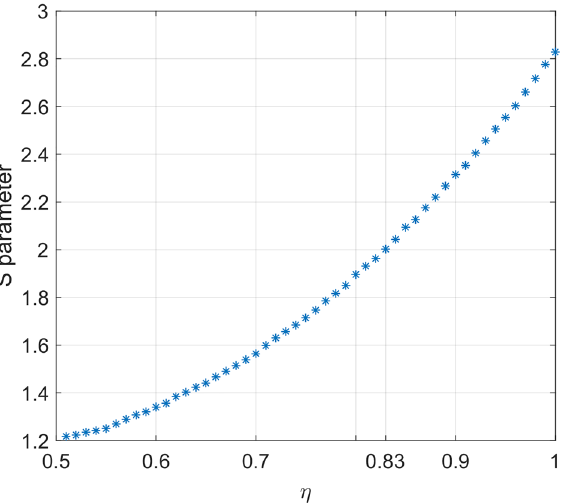
Figure 11. Effect of non-unity value of detectors efficiency on the S parameter. It is seen when detector efficiency in this example is 0.83, mean value of S parameter is about 2. In this example each star corresponds to the mean value of 50 runs, in each run 5000 photons considered with defined detector efficiency, while other parameters are same as those of Fig.